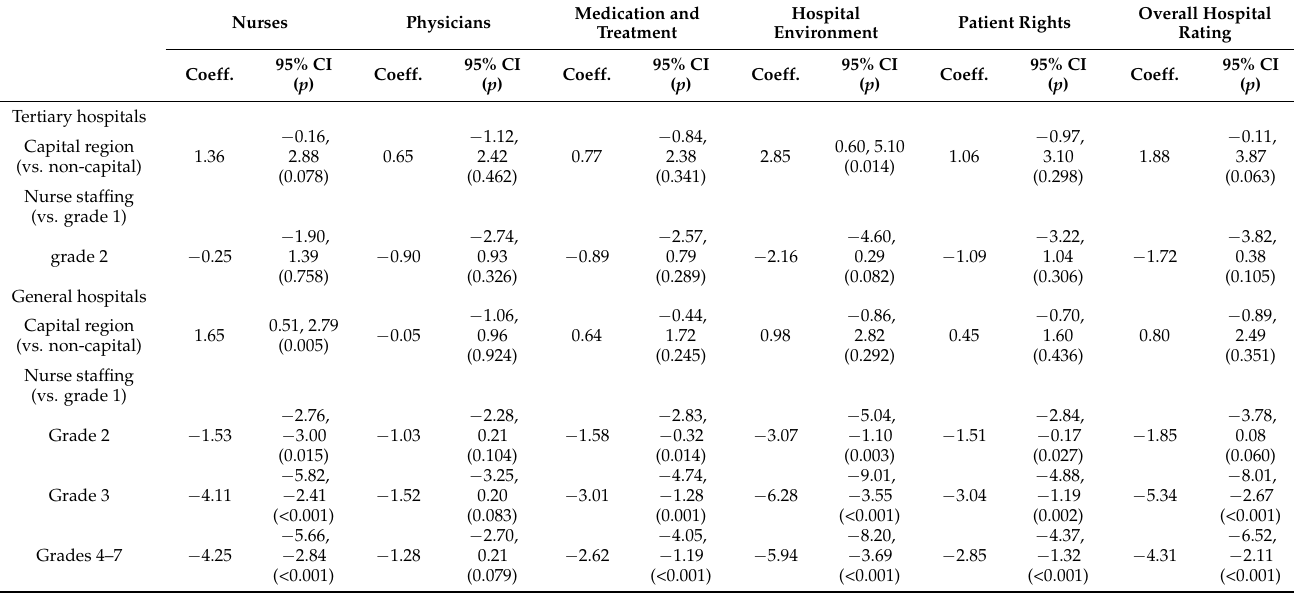
Table 3. Simple regression results for patient experience dimensions (n =